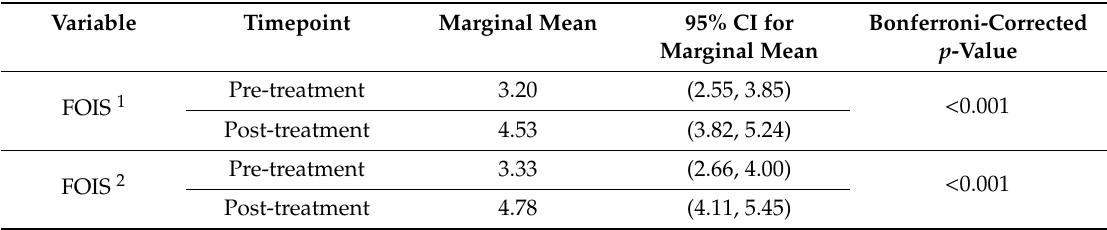
Table 7. Estimated marginal means of primary outcome measure pre- and